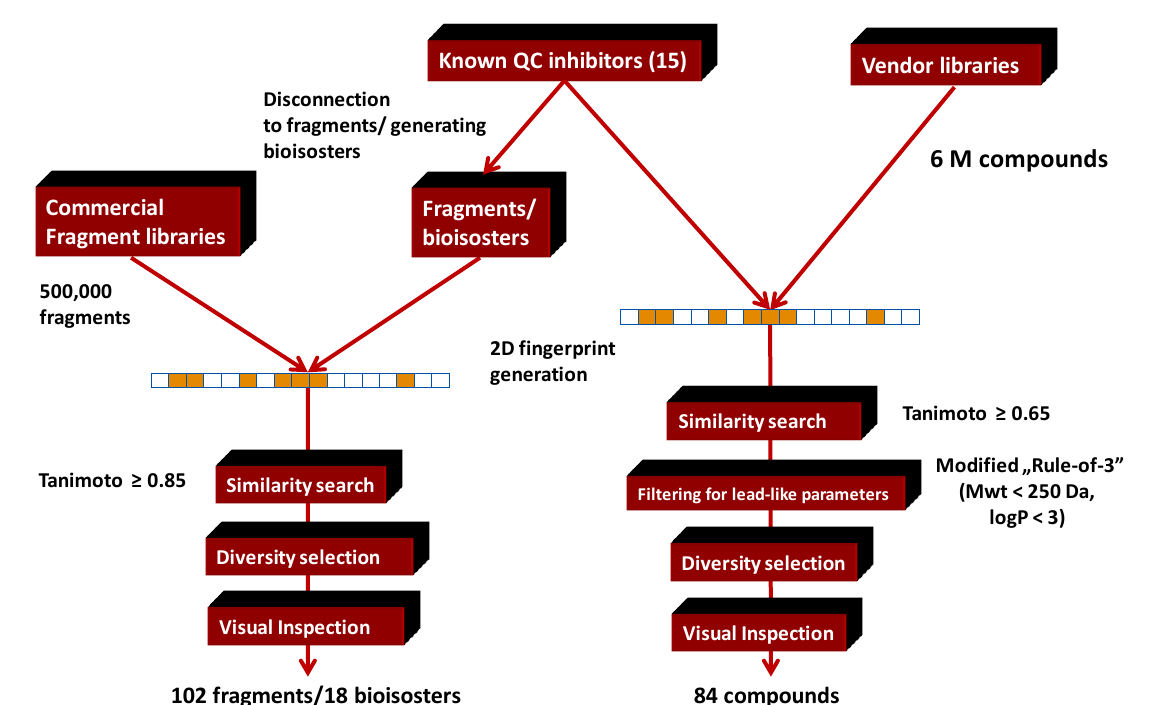
Figure 14. Fragment-based approaches combined with 2D similarity search.